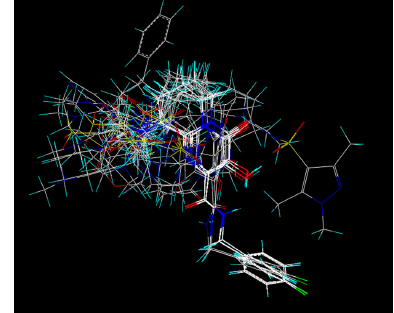
Figure 1. Atom based alignment of bicyclic pyrimidinones on